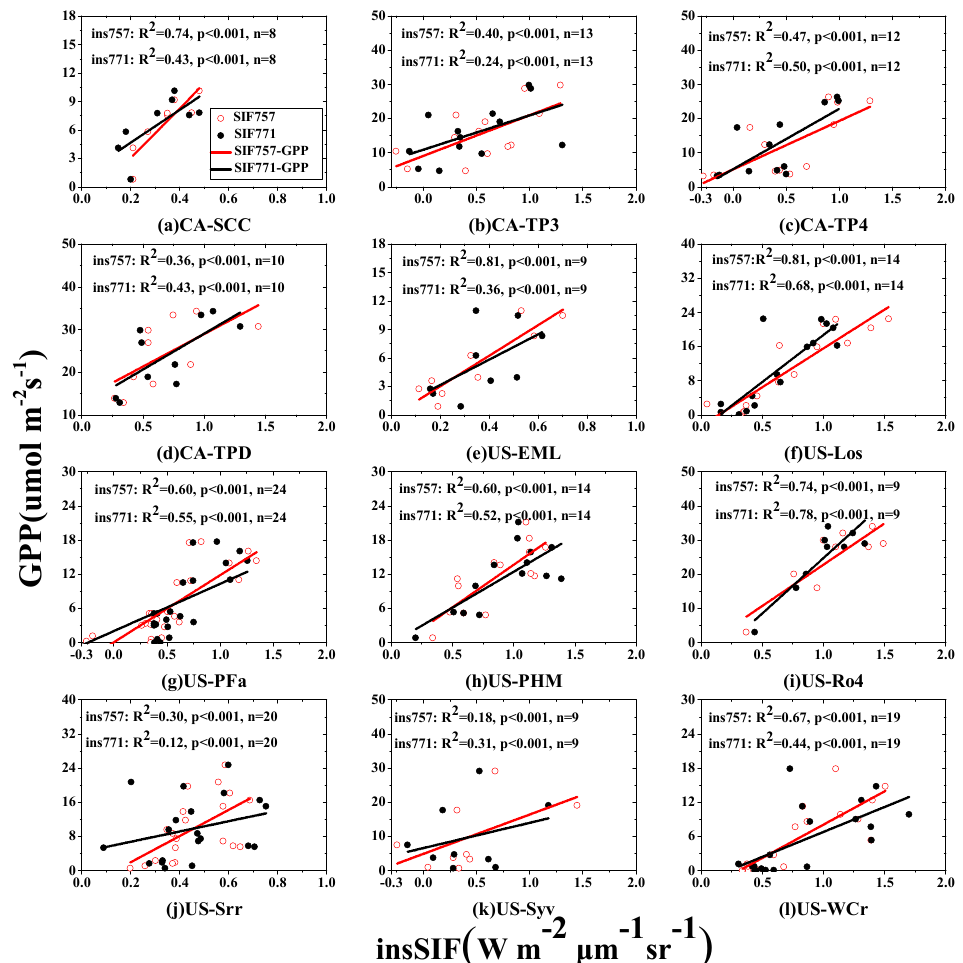
Figure 3. The linear relationship between instantaneous solar-induced chlorophyll fluorescence (SIF) and instantaneous gross primary productivity (GPP) for different EC flux towers. The red circle represents the data of ins757 while the black dot represents the data of ins771. The linear relationships are presented in colorful lines for different independent variables.